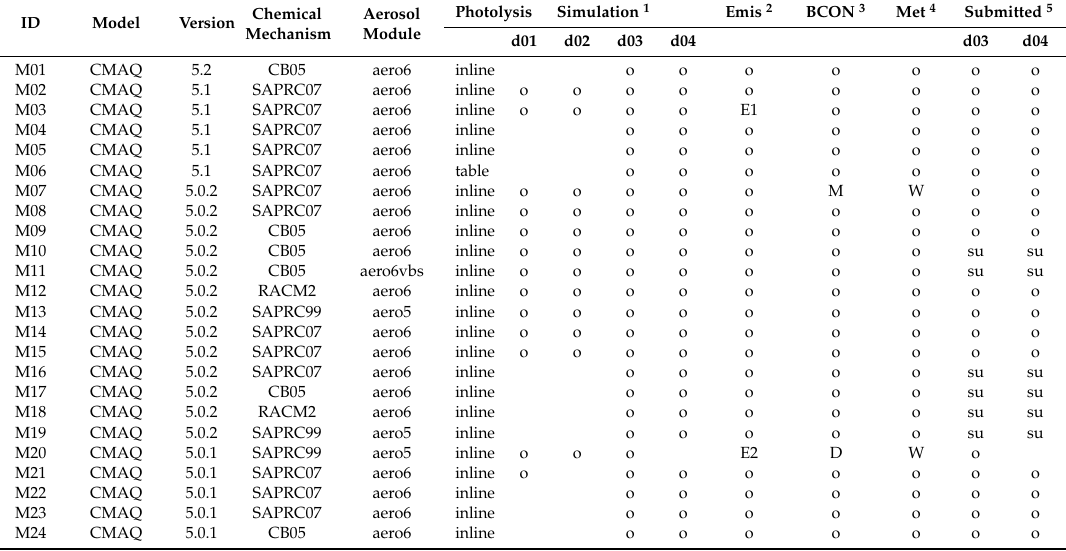
Table 2. Configurations of participant chemical transport models (CTMs) submitted for J-STREAM Phase I, updated from an overview of J-STREAM